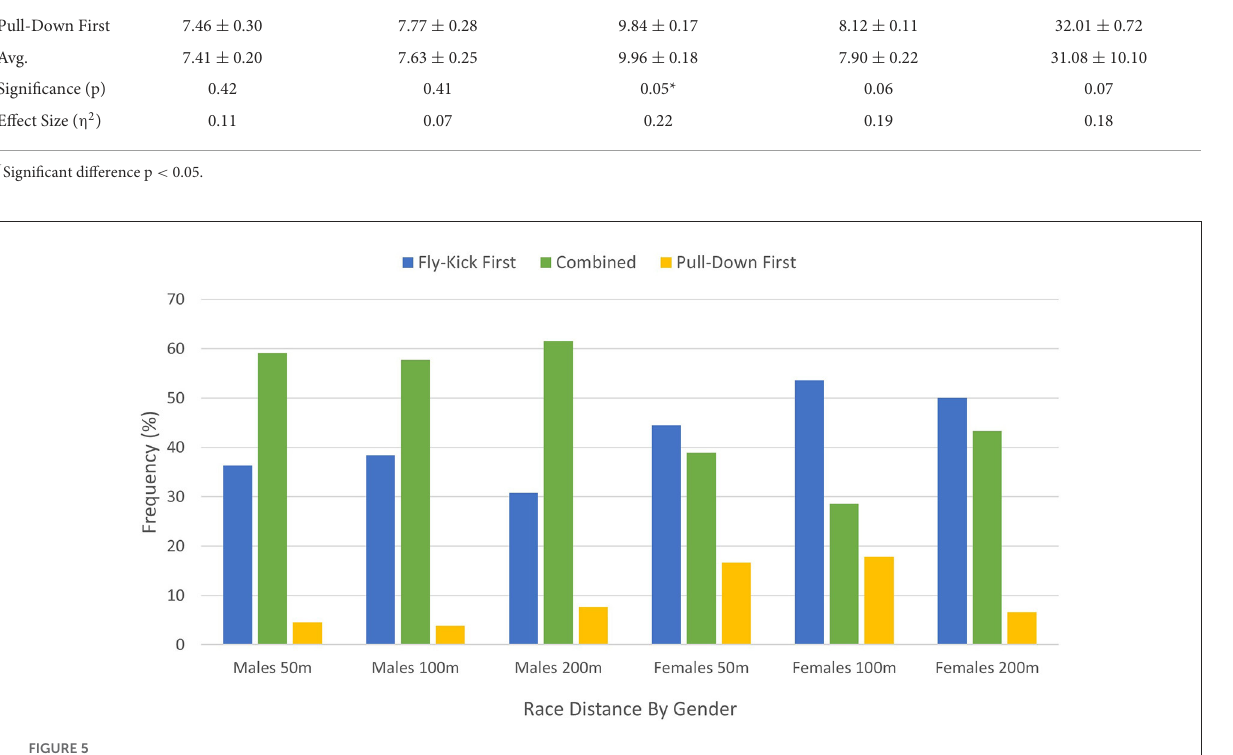
FIGURE5 Underwater breaststroke pullout trends across all race distances for male and female elite